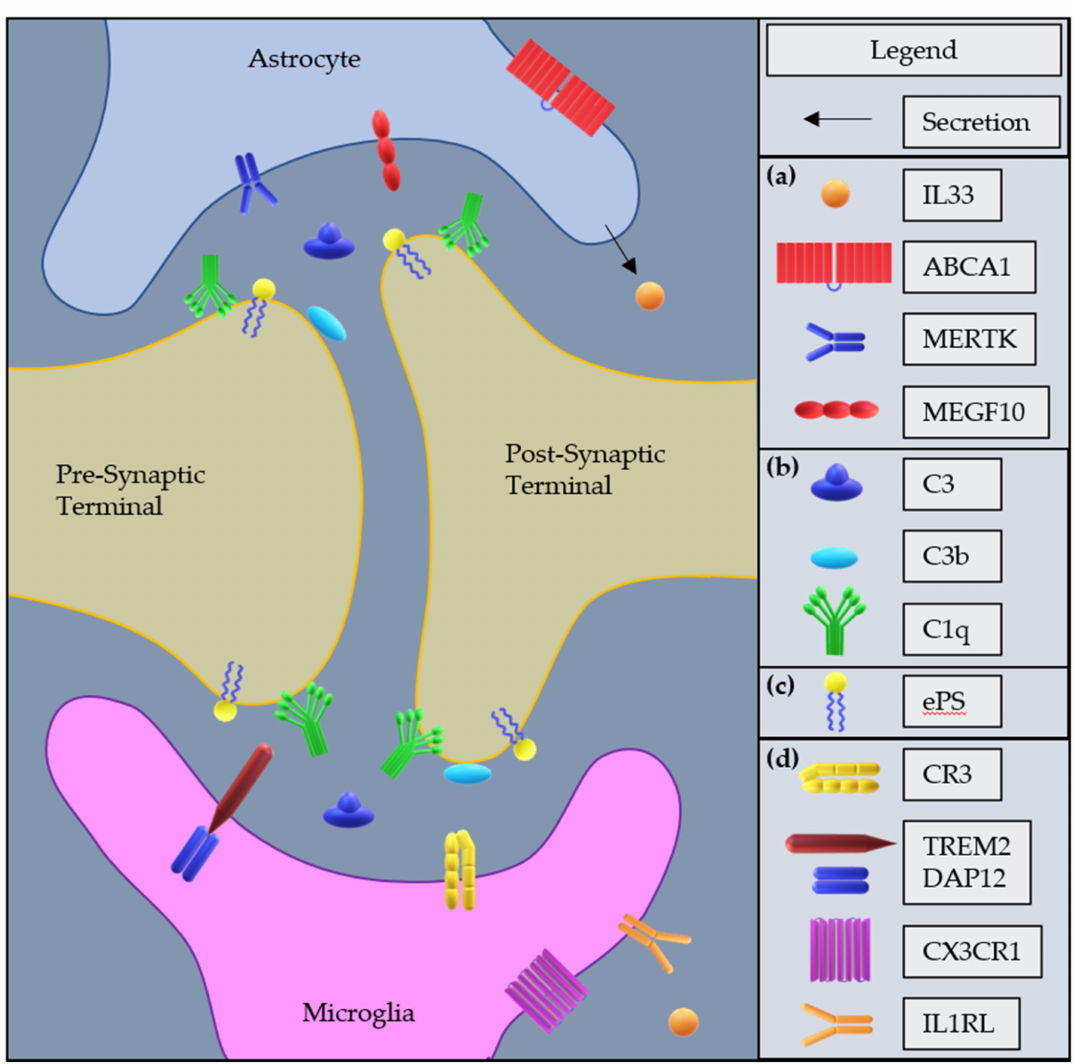
Figure 1. Potential molecular mechanisms of microglia- or astrocyte-mediated synaptic pruning: ( a ) Astrocyte factors mediating synaptic pruning activity; IL33 is secreted by astrocytes and upregu- lates the pruning activity of microglia, ABCA1 is an upstream modulator of MEGF10, MERTK and MEGF10 are phagocytosis receptors that recognize “eat-me” signals. ( b ) Complement components C3b and C1q are opsonins that mark synapses for phagocytosis. ( c ) Externalized